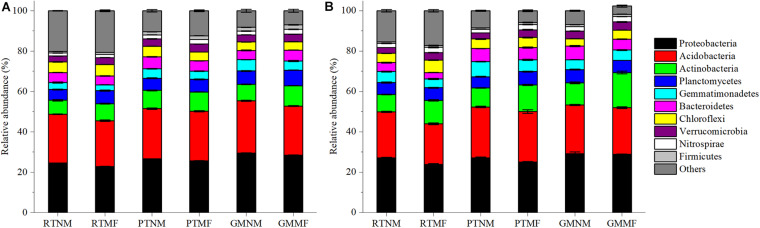
Relative abundance of major taxonomic groups at the phylum level for bacteria in 0–10 cm (A) and 10–20 cm soil layer (B). Relative abundance of top 10 phyla is displayed in different colors. Vertical bars represent standard error (SE). Mean values ± SE (n = 3).